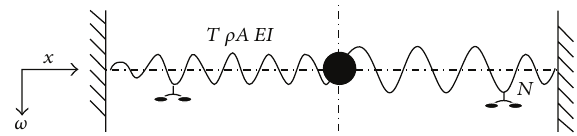
Figure 5: Schematic view of a typical long-span transmission